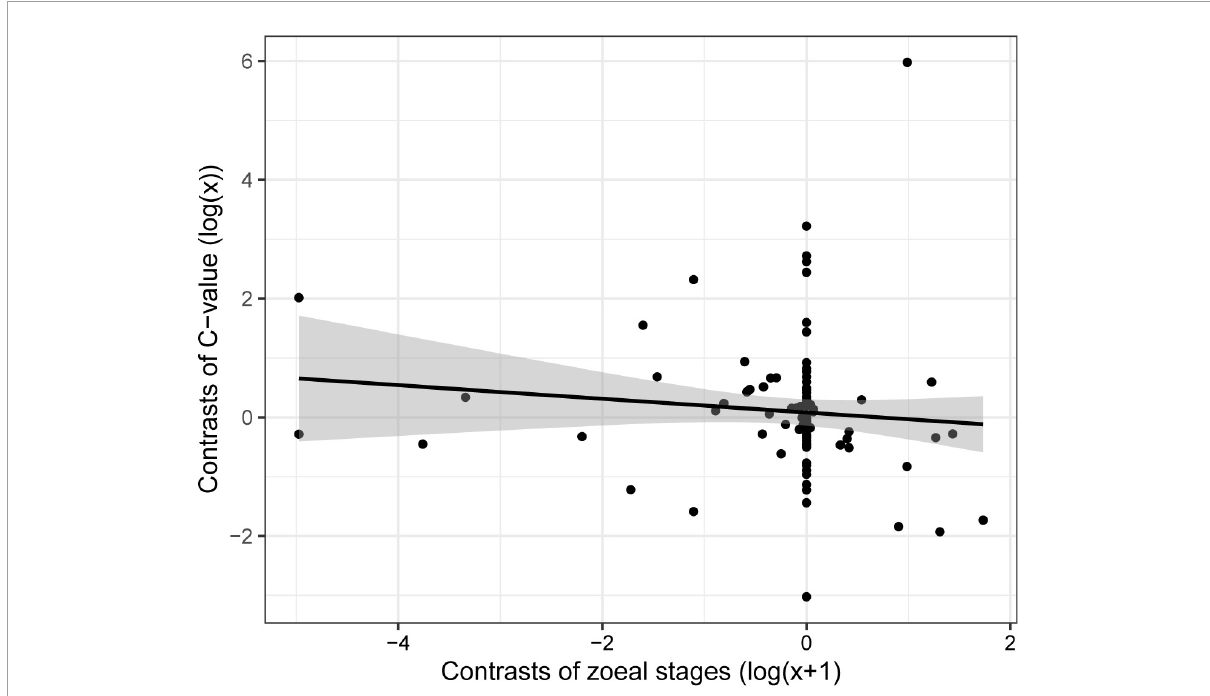
FIGURE5 Correlation between genome size and number of zoeal stages in species of decapods belonging to the infraorders Anomura, Astacidea, and Brachyura, using phylogenetic independent